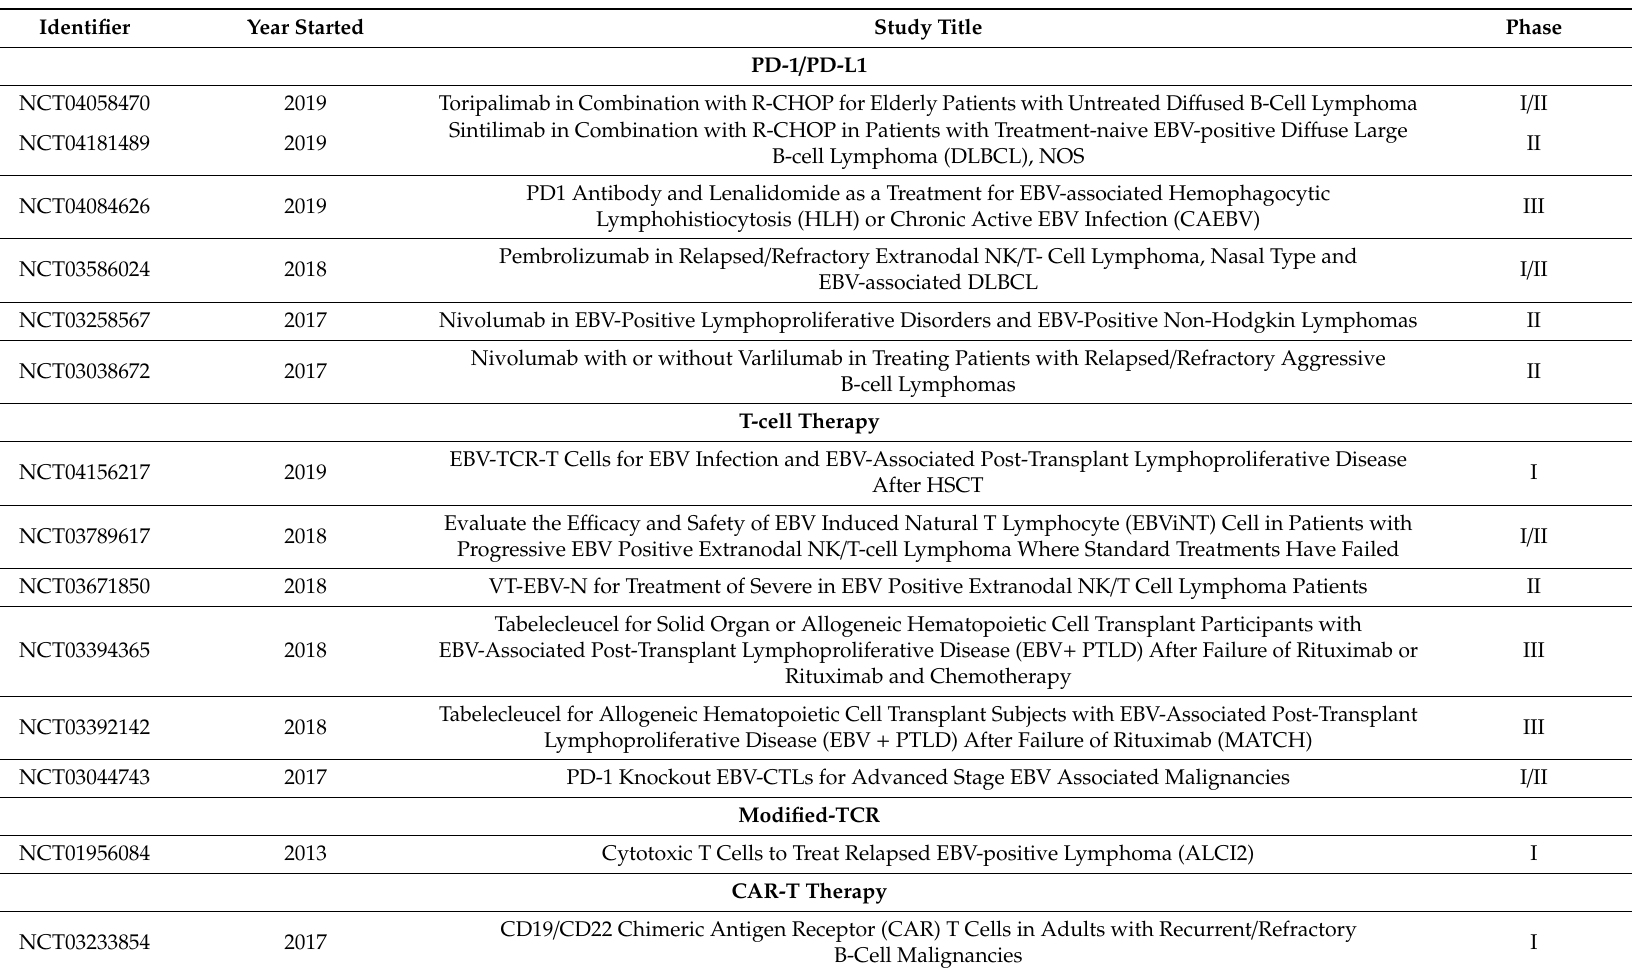
Table 1. Representative active clinical trials on treating EBV-associated